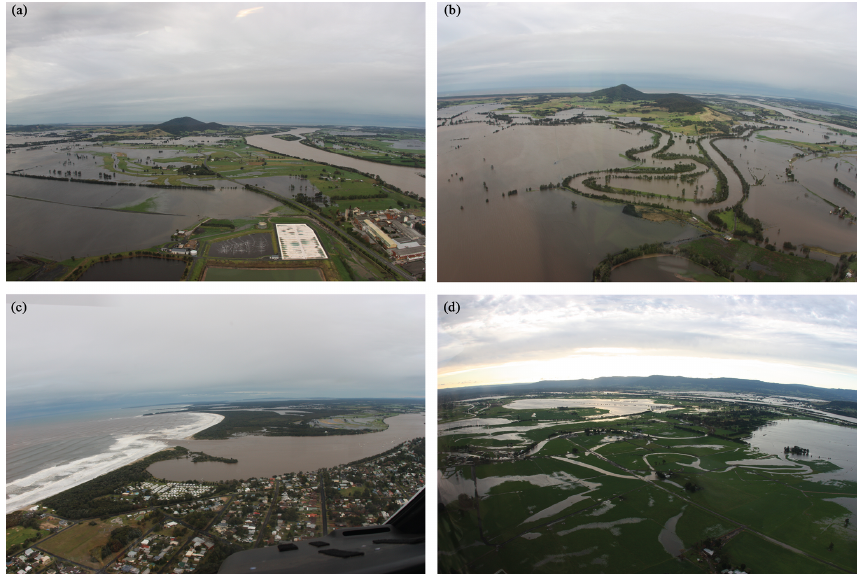
Figure 4. Selection of aerial photographs taken by the Shoalhaven City Council on 6 June 2016 around 17:00:00LT showing the flood extent of the June 2016 storm event. Looking from Nowra towards east into Broughton Creek floodplain (a) , looking from Broughton Creek floodplain towards east (b) , looking from Shoalhaven Heads towards south at the breached entrance and Comerong Island (c) and looking from Greenwell Point towards north-west (d) into Crookhaven floodplain.